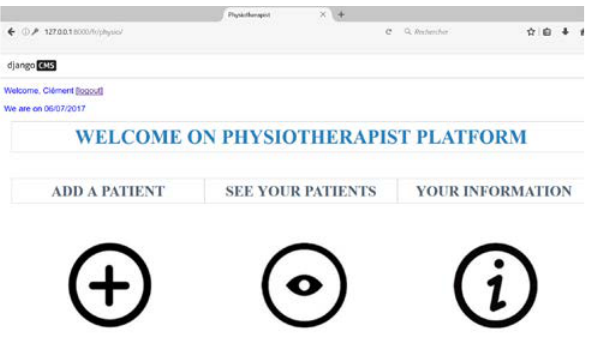
Figure 5 | Physiotherapist interface (main